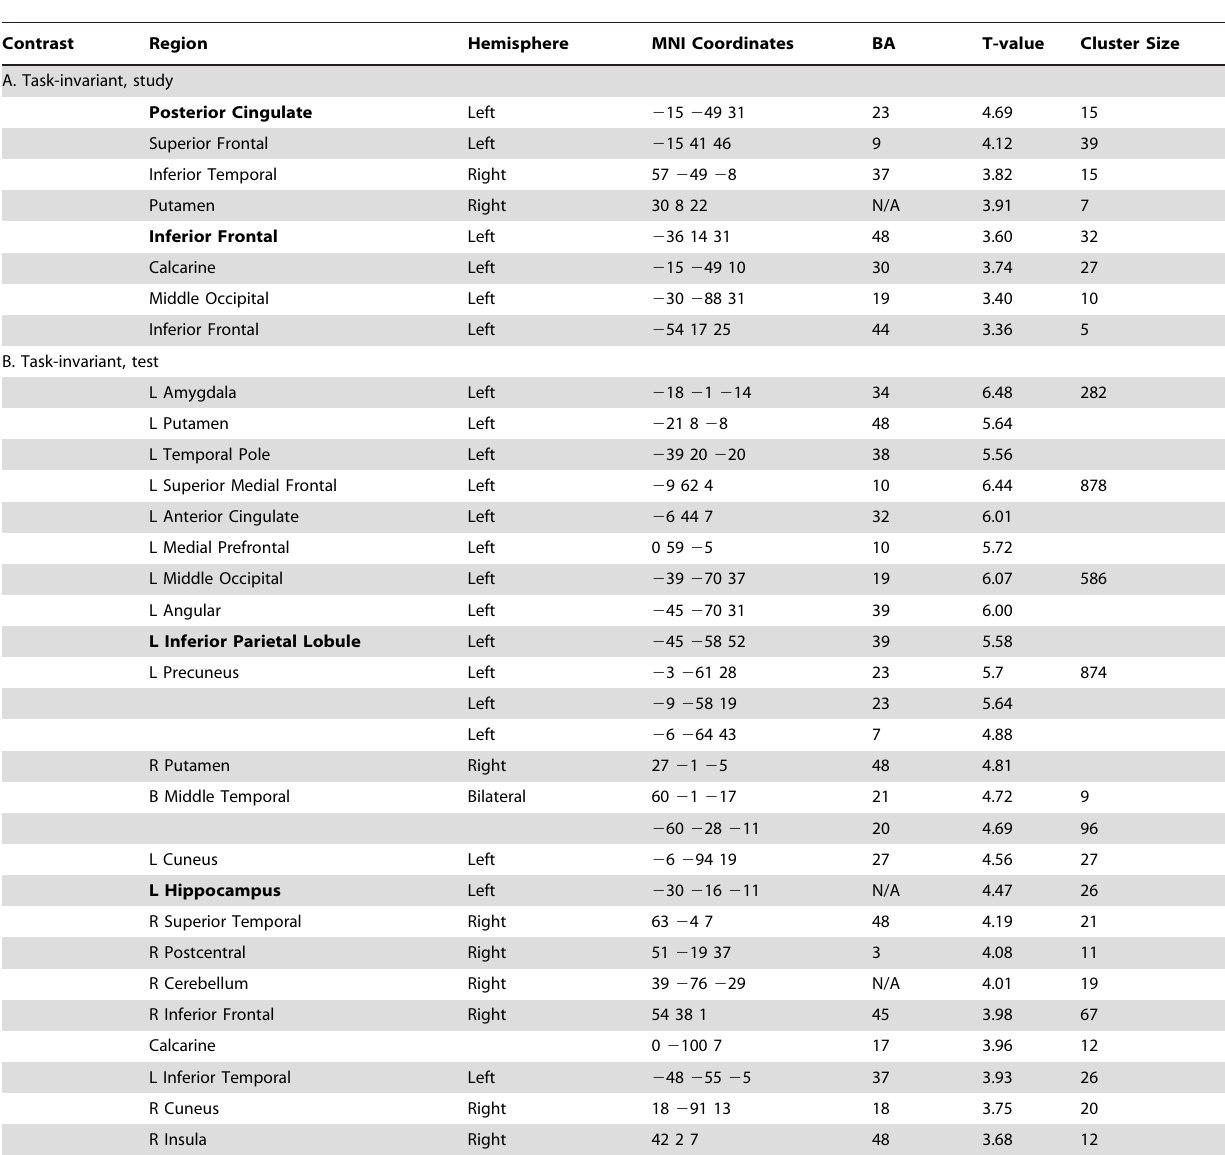
Task-invariant regions were defined by exclusively masking subsequent memory regions (Hits . Errors) with regions showing the memory by condition interaction. Regions are listed from highest to lowest t -value. Regions listed without a cluster size are subsumed by the larger cluster listed directly above. Regions listed in bold are depicted in Figure 4. BA: Brodmann area.